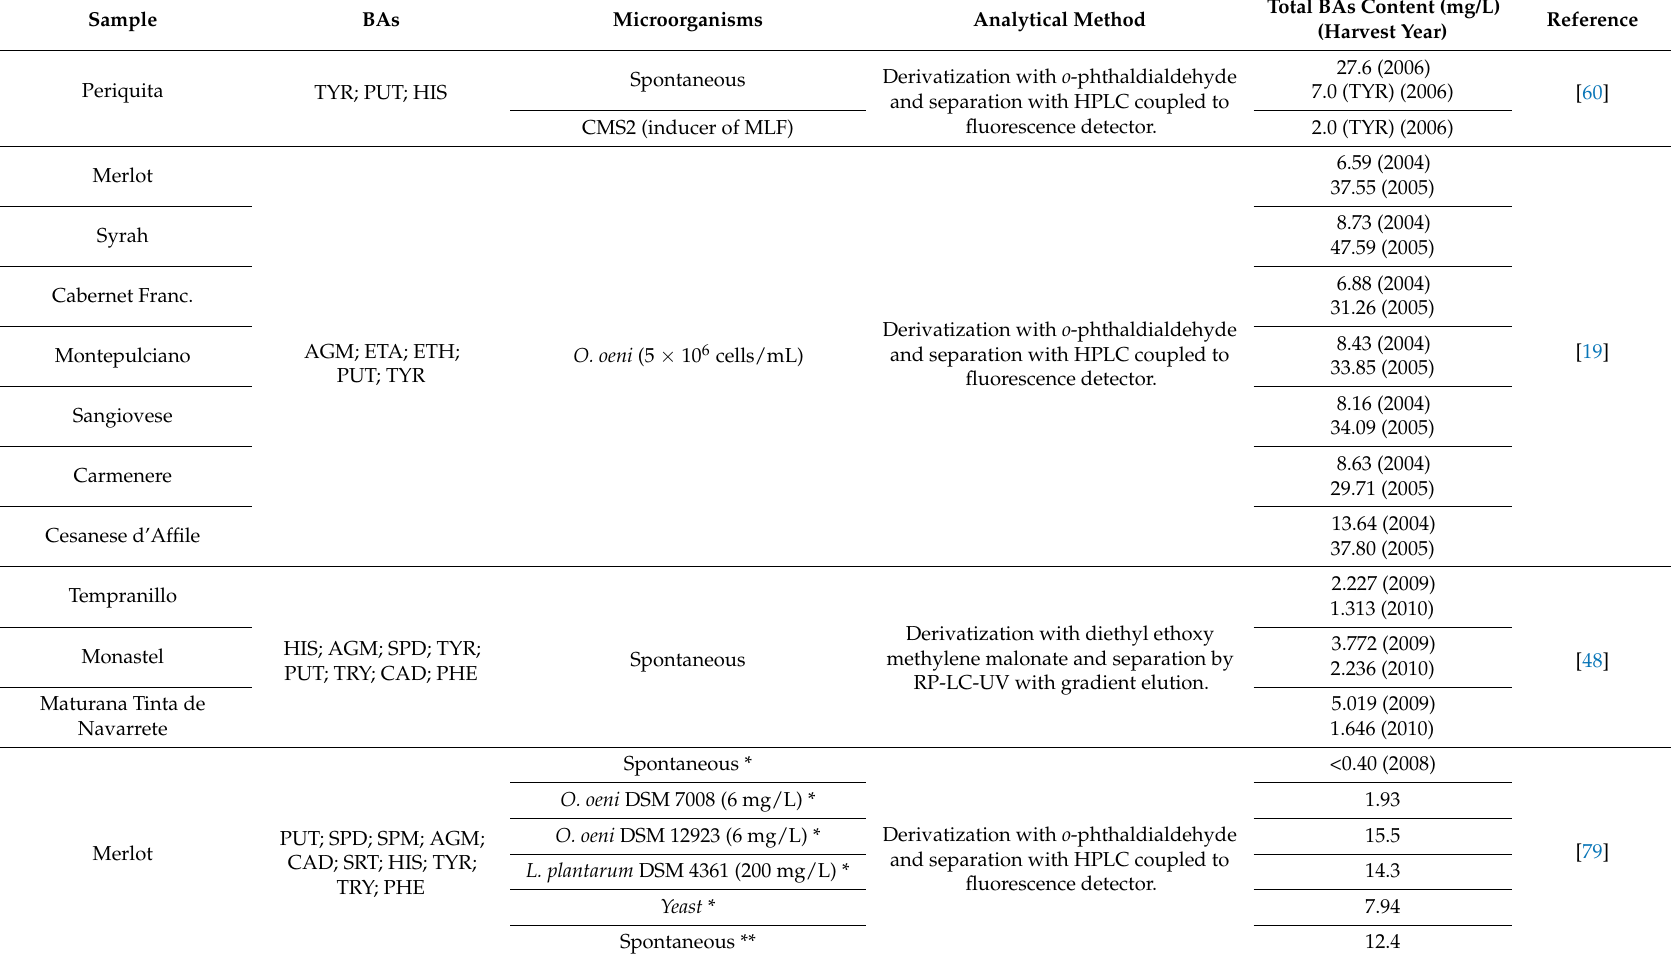
Table 2. BAs determination in wines after malolactic